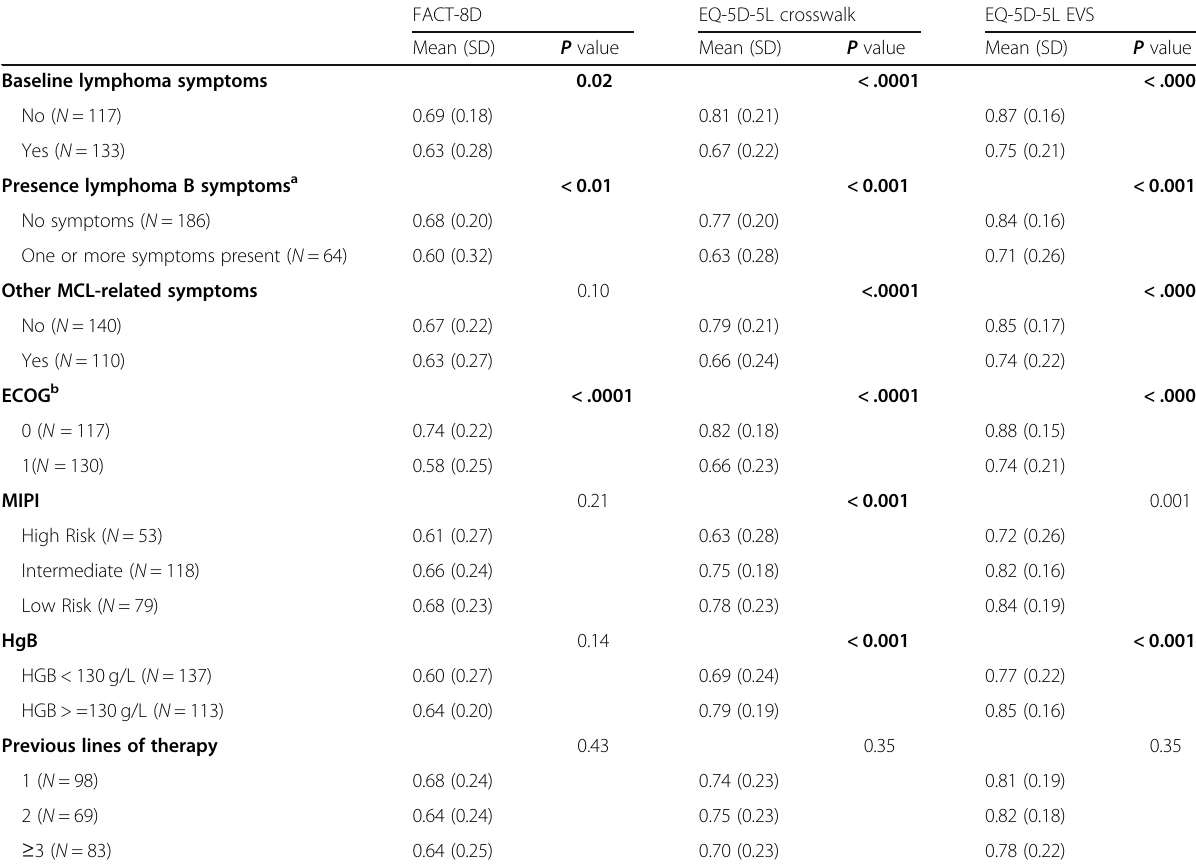
Table 2 Known groups ’ validity for FACT-8D and EQ-5D-5L Index scores, using baseline data FACT-8D EQ-5D-5L